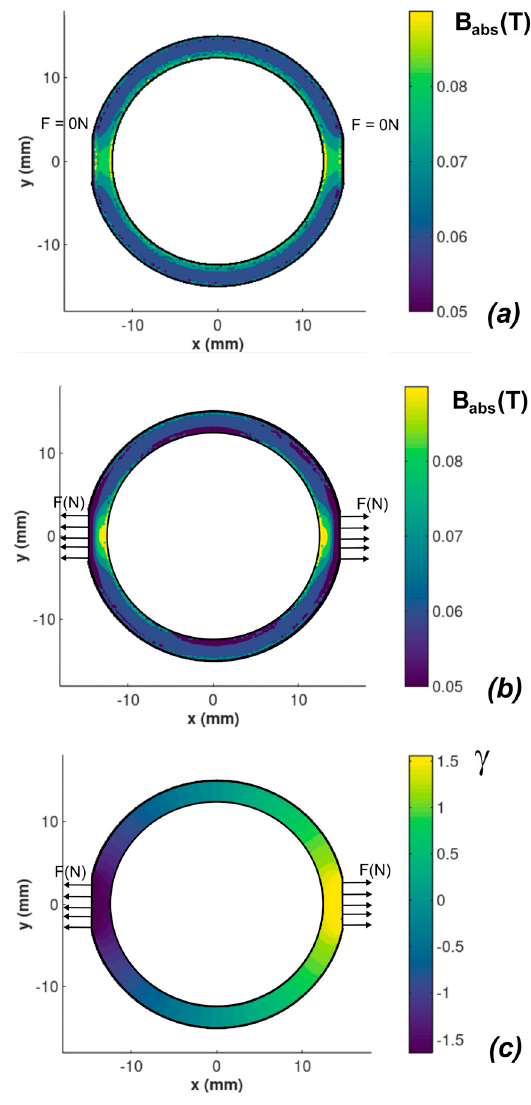
Figure 4. The flux density B distribution in the core of the magnetoelastic sensor subjected to mechanical stresses generated by the force F , ( a ) absolute length of the flux density B vector for sample not subjected to stresses ( F = 0 N), ( b ) absolute length of the flux density B vector for sample subjected to stresses F = 50 N, ( c ) in γ between the flux density B and x-axis for sample subjected to stresses F = 50 N.